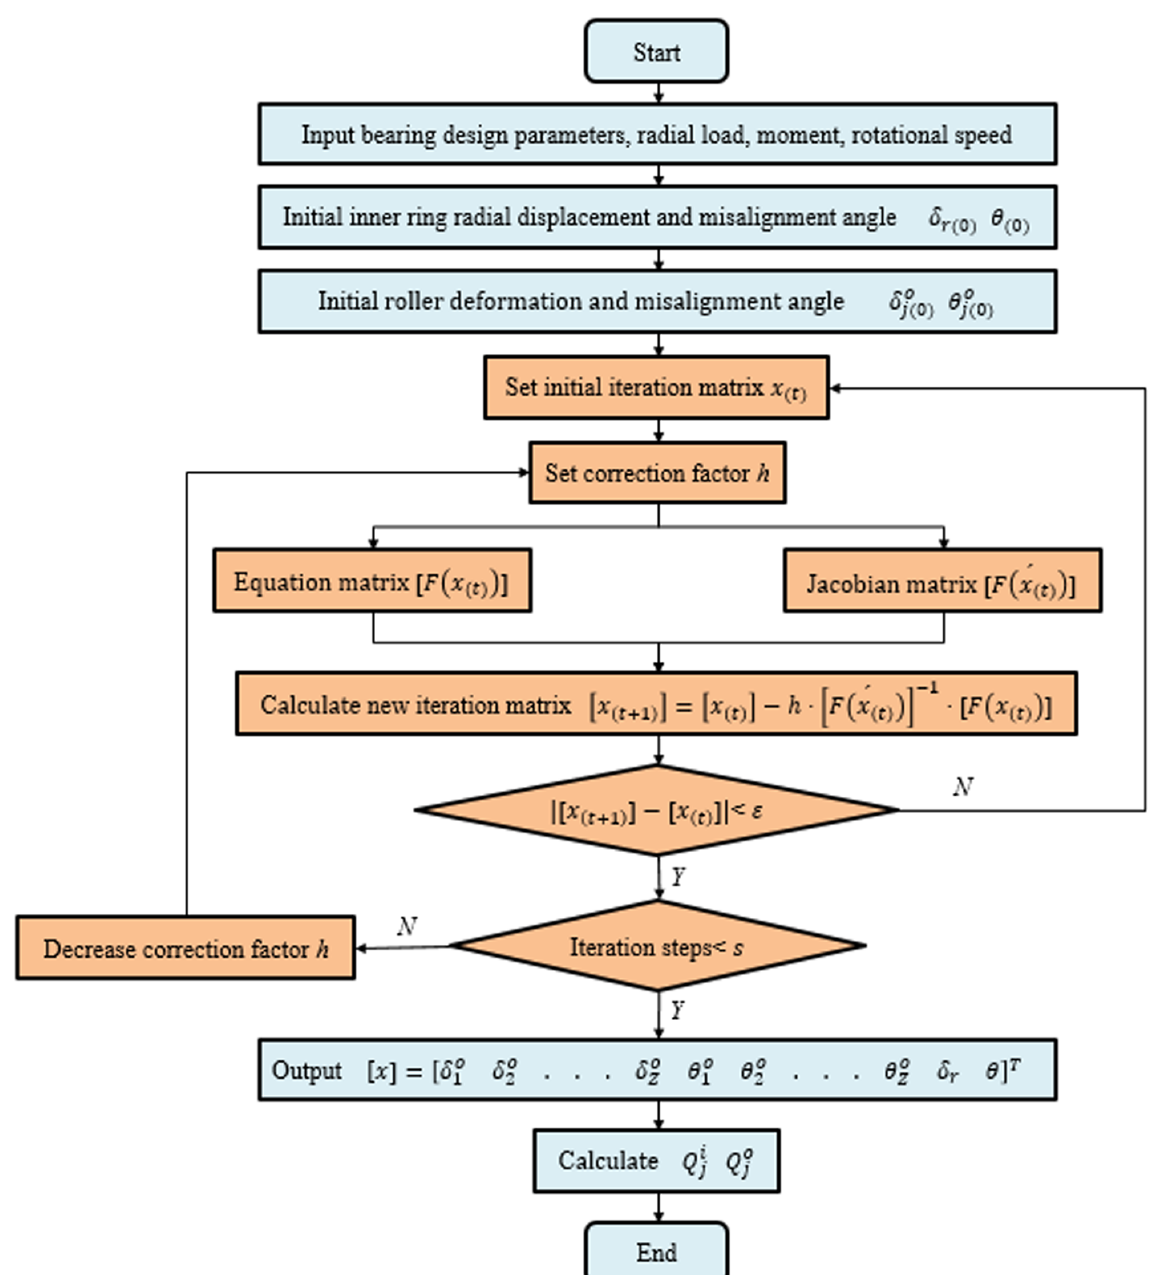
Fig. 5. The solution procedure of numerical